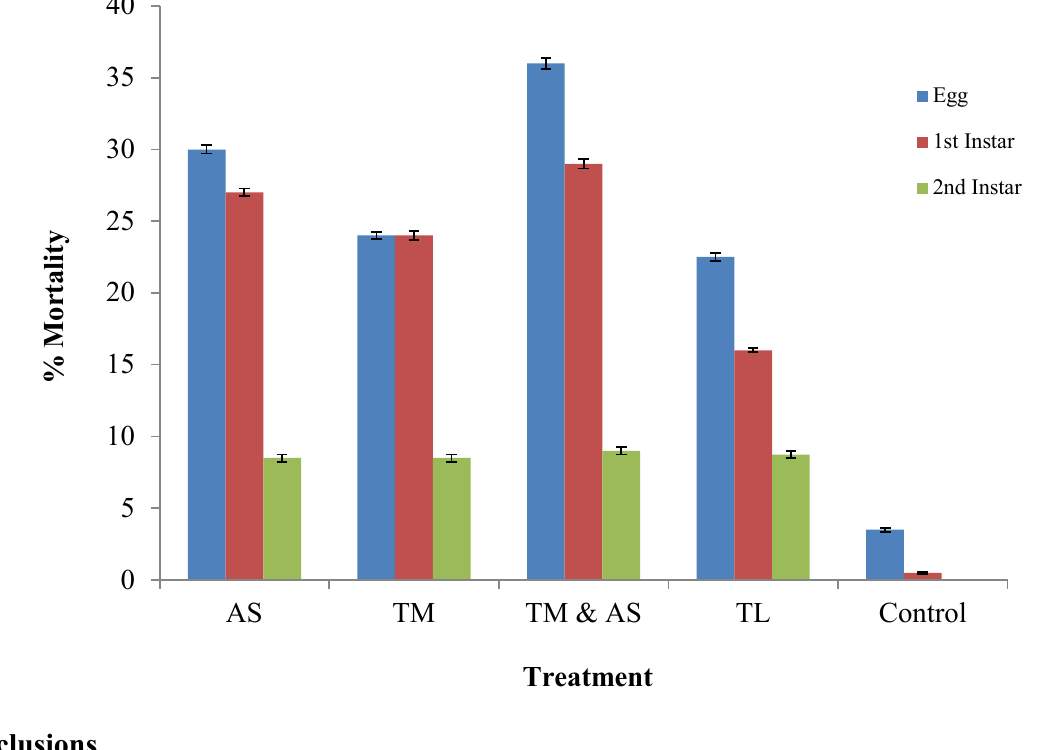
Figure 2. The impact of predatory mites against Bemisia tabaci Mediterranean lifestages. Mortality assessed following 5 days. AS— Amblyseius swirskii ; TM— Transeius montdorensis ; TL— Typhlodromalus limonicus